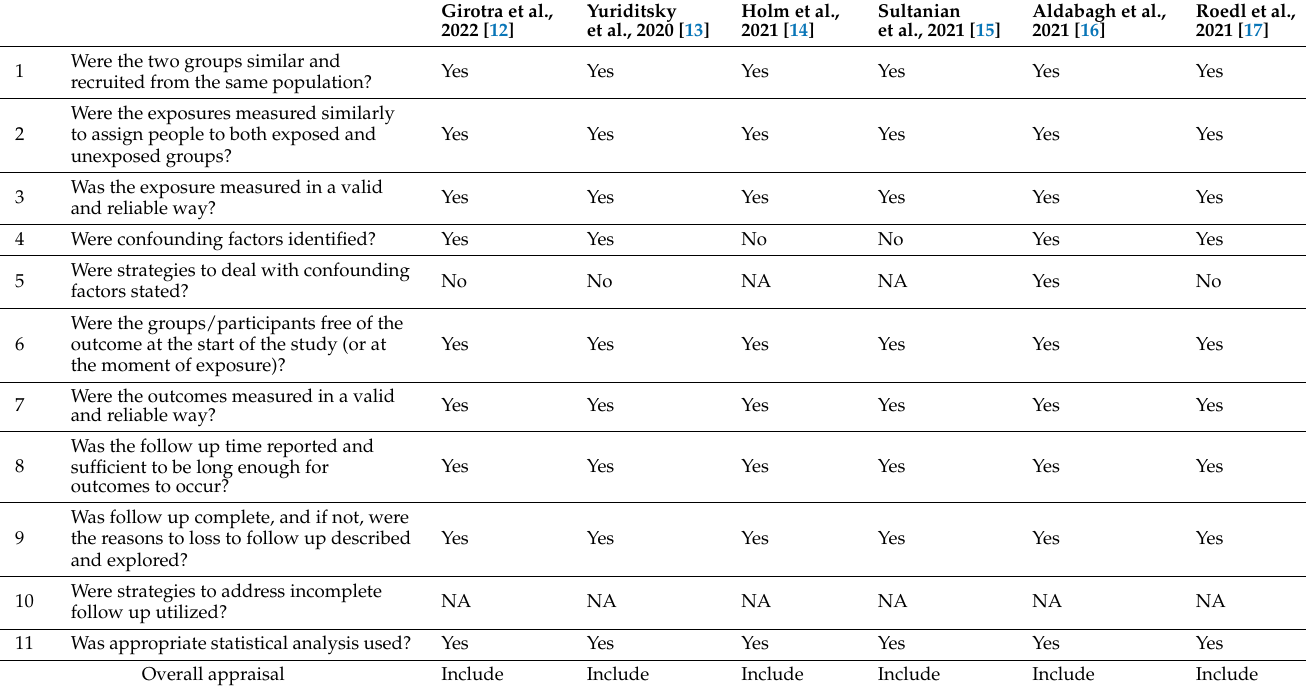
Table 1. Critical appraisal tool for the assessment of the risk of